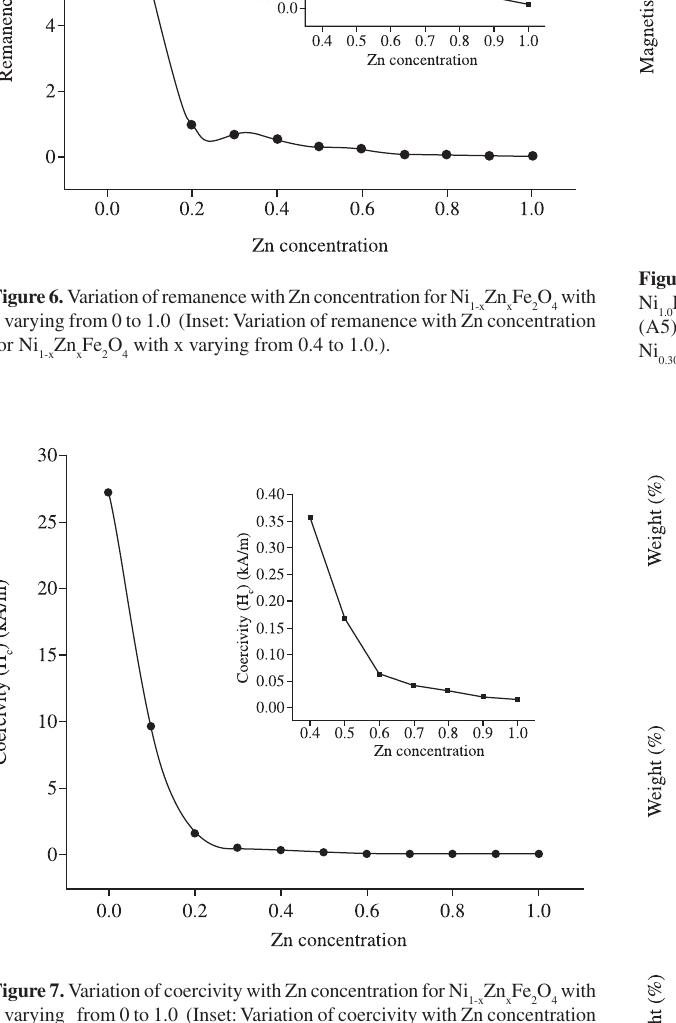
Zn Fe O with 1-x x 2 4